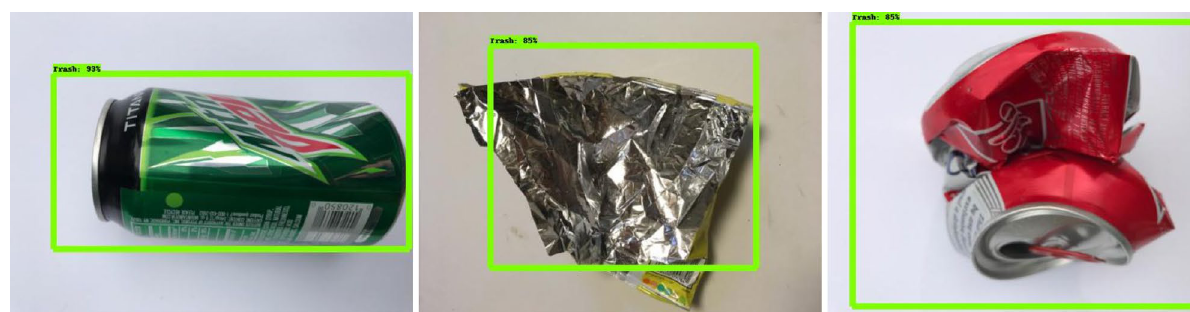
Figure 12. Trashnet data-set detection result.